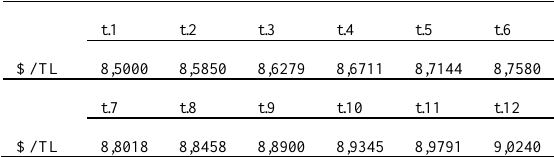
Table 3. Dollar exchange rate estimates in Turkish Liras